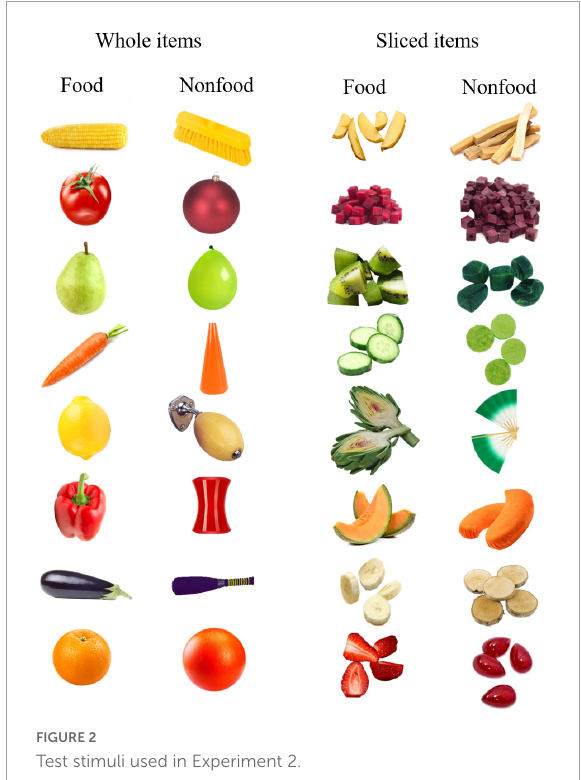
FIGURE2 Test stimuli used in Experiment 2.